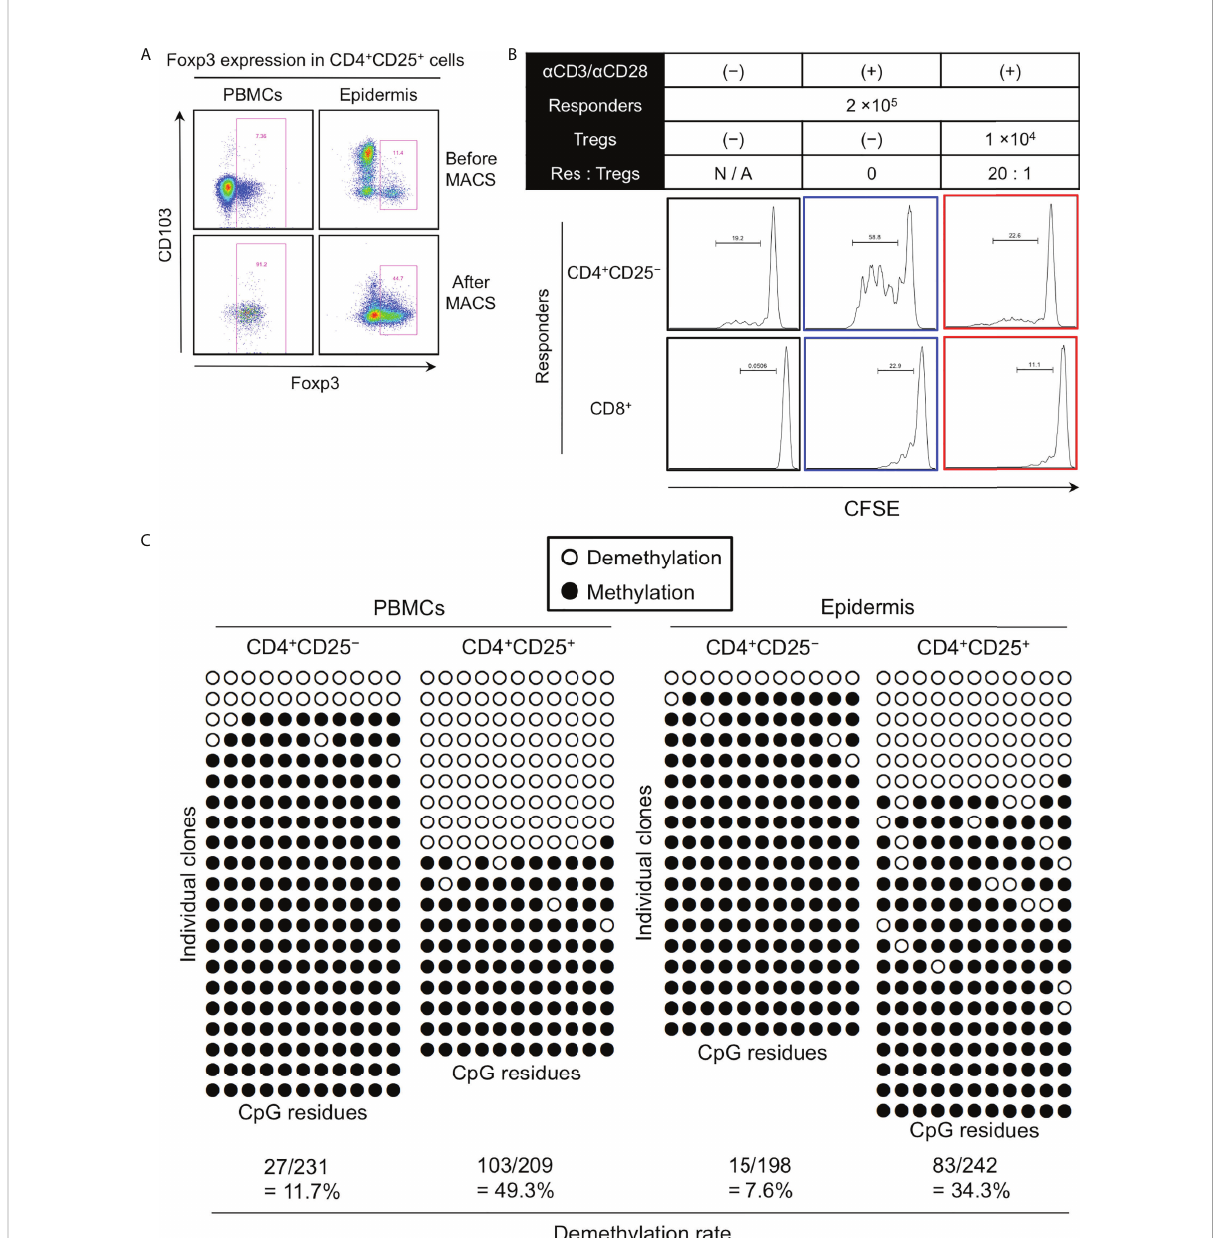
FIGURE 7 Highly demethylated FOXP3 in the epidermal CD4 + CD103 − cells. (A) Representative Foxp3 and CD103 expression in CD4 + CD25 + cells of PBMCs and epidermal emigrants before and after magnetic sorting. (B) Representative CFSE expression in the indicated responders. (C) Representative genomic DNA demethylation in the FOXP3 gene of CD4 + CD25 − and CD4 + CD25 + cells from PBMCs and the epidermis. All representative data were obtained from a single experiment due to the limited availability of huge skin samples that were required to conduct the